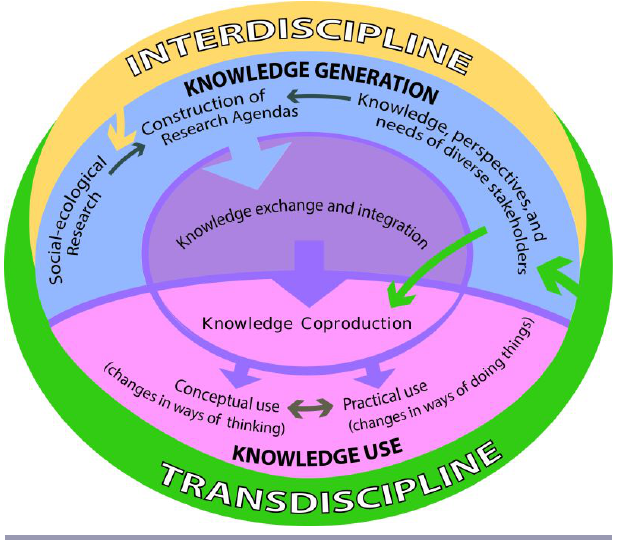
Fig. 2 . Knowledge generation, its exchange, integration, and utilization are integrated in the same system that contributes to inter- and transdisciplinary social-ecological systems (SES) research. The arrows connect the different aspects highlighted in the aforementioned processes. The actors involved are researchers (easily recognized on the left side as responsible for SES research) but also nonacademic stakeholders participating in inter- and transdisciplinary work. Emphasis is made on the construction of research agendas with diverse actors who bring knowledge, perspectives, and needs. It is through processes of exchange and integration that knowledge coproduction can occur and knowledge used, either to change actors’ ways of thinking or their ways of doing things (both scientists and other